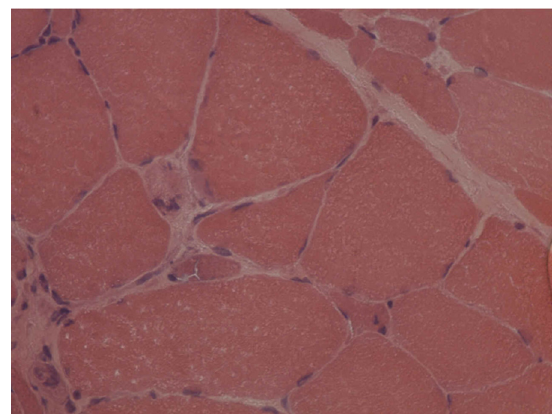
Figure 5 Presence of polygonal muscular atrophy and rimmed vacuoles (hematoxylin---eosin stain, 350 ×